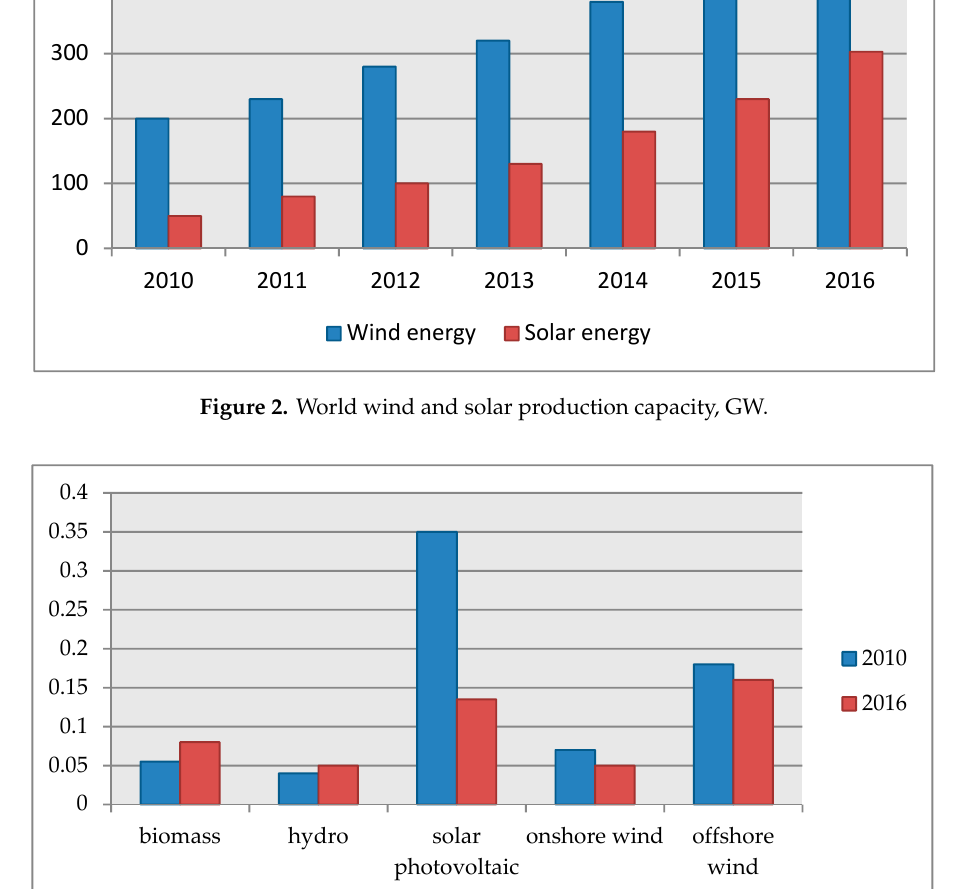
Figure 3. Estimated cost of electricity on renewable energy installations, US dollars per kWh.